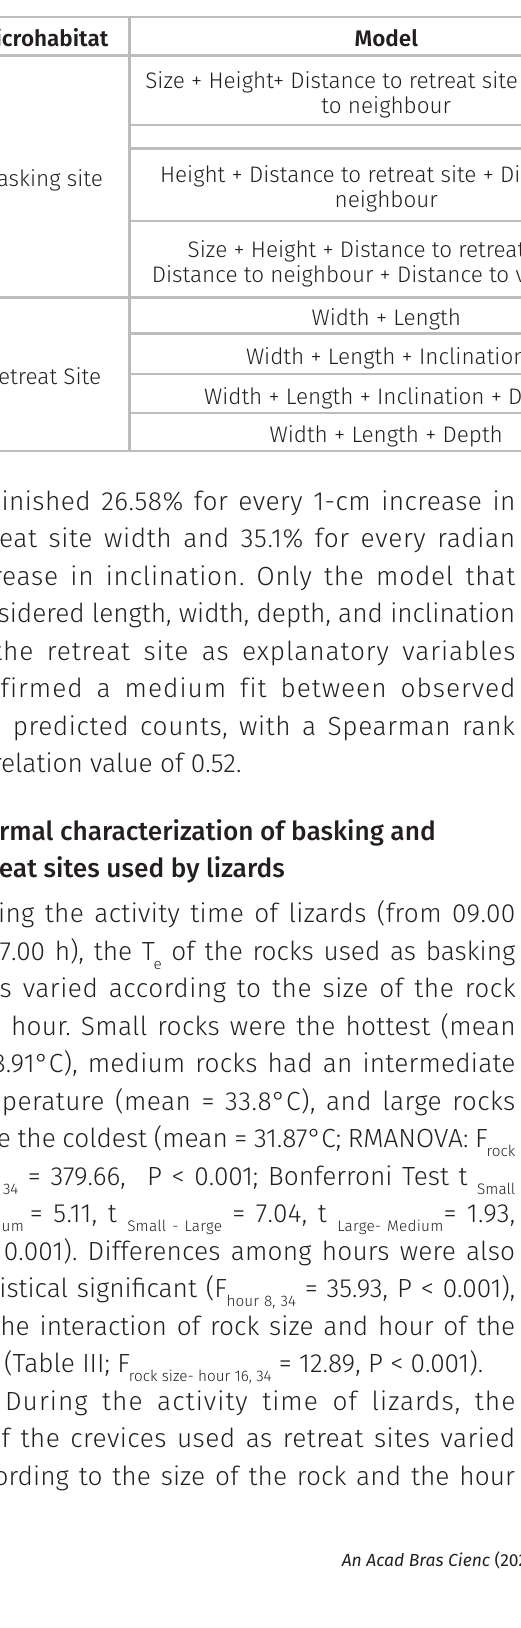
Table I. The three best models of basking sites selection and the four best models of retreat sites for Phymaturus palluma. Model parameters (K), AICc for each model, differences between the model with the lowest AICc and each model (ΔAICc) and Akaike